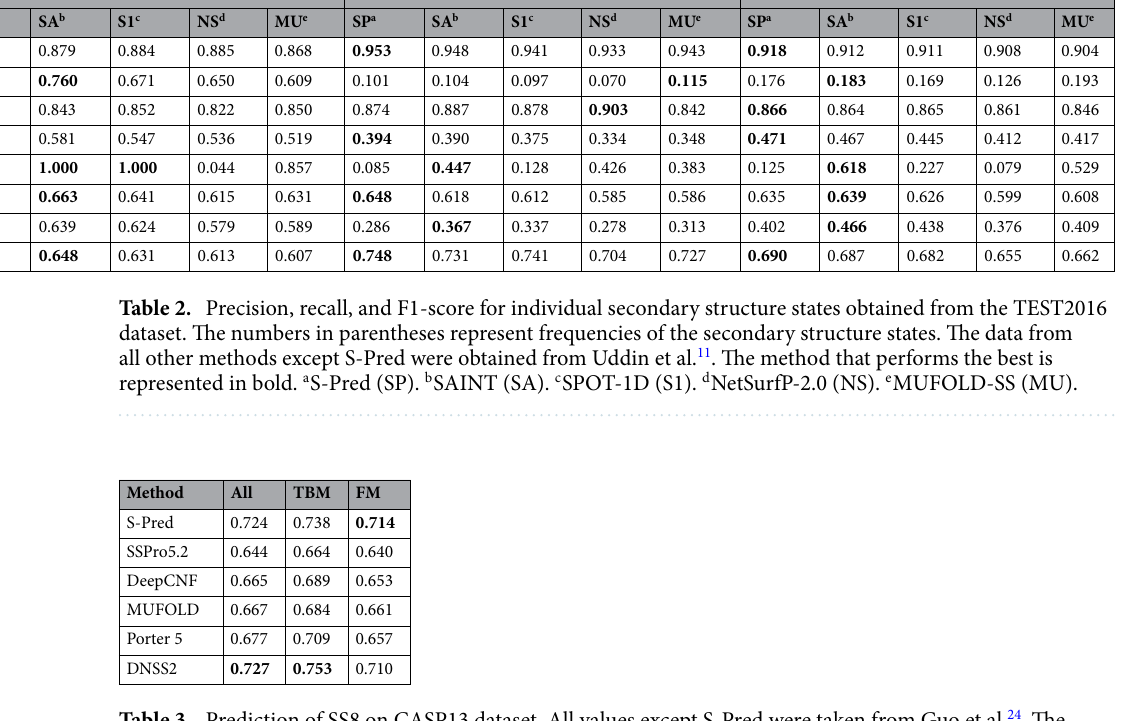
Table 3. Prediction of SS8 on CASP13 dataset. All values except S-Pred were taken from Guo et al. 24 . The method that performs the best is represented in